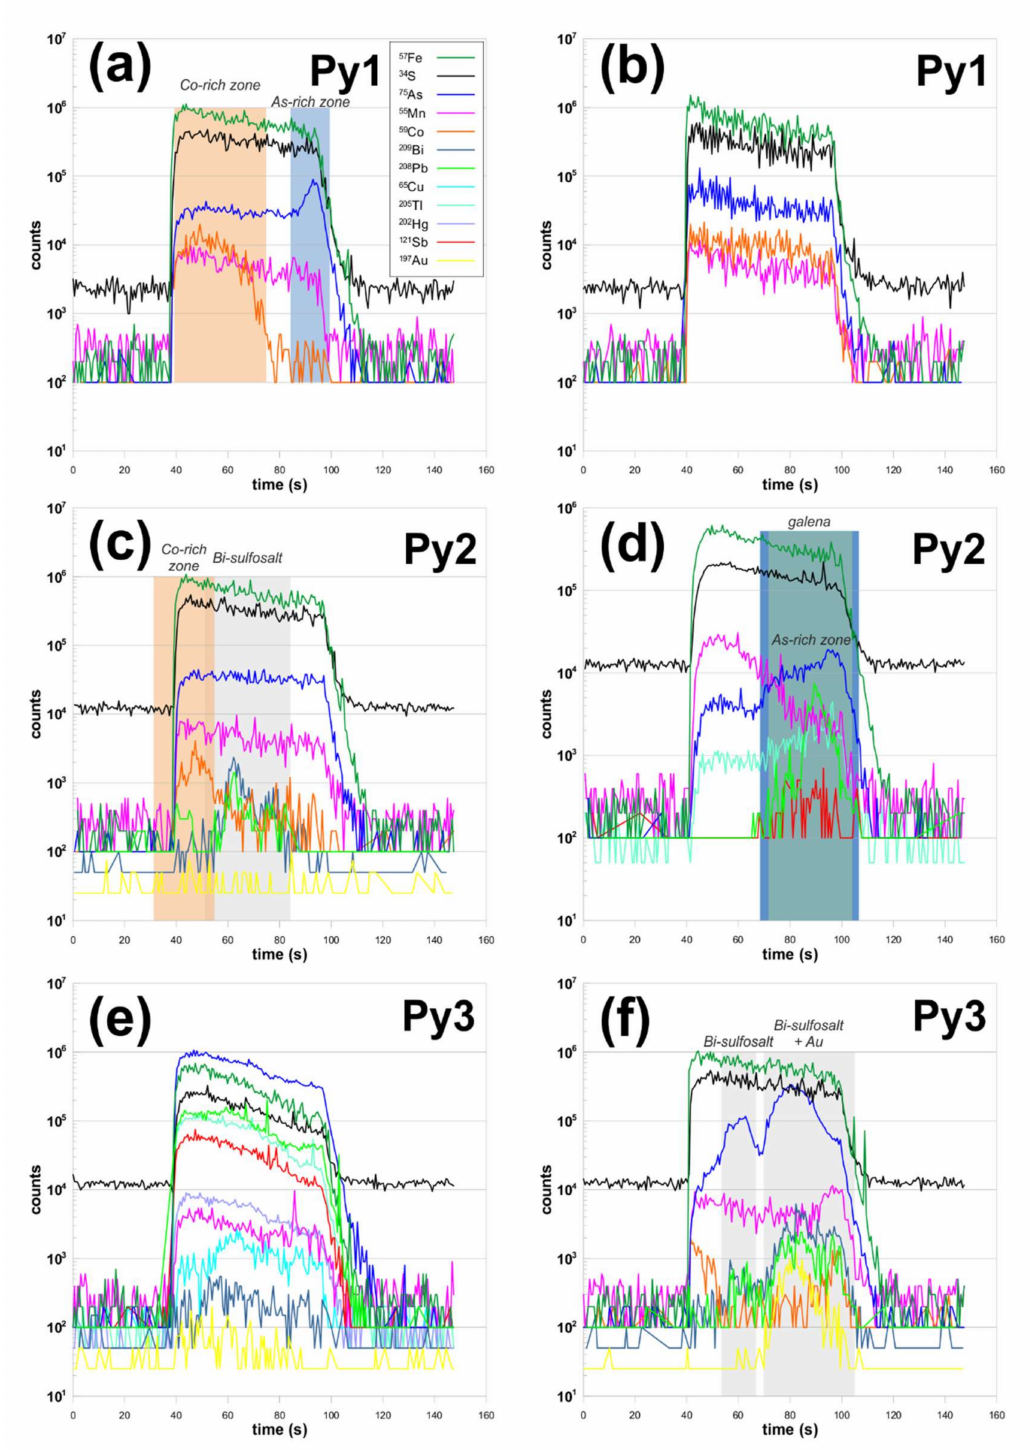
Figure 10. Representative time-resolved laser ablation ICP-MS depth profiles of pyrite, Co, and As-rich zones (highlighted in orange) in pyrite (highlighted in blue) and associated inclusions (highlighted in gray and green) from the Kizhnica quarry. ( a ) Spectra of pyrite 1 with Co and As-rich zone; ( b ) flat spectra of pyrite 1; ( c ) spectra of Py2 with Co-rich zone, the distribution patterns of Bi and Pb could be related to inclusions of Bi-Pb sulfosalt; ( d ) spectra of pyrite 2 enriched in As and Tl, while Pb and Sb are related to galena inclusion and As-rich zone; ( e ) relatively flat spectra of pyrite 3, and the similarly curved distribution patterns of Bi and Cu could be related to inclusions of Bi-Cu sulfosalt; ( f ) spectra of Py3 with variable As content, and the spiky patterns of Bi, Pb, and Au could suggest the occurrence of Bi-Pb inclusions with possible